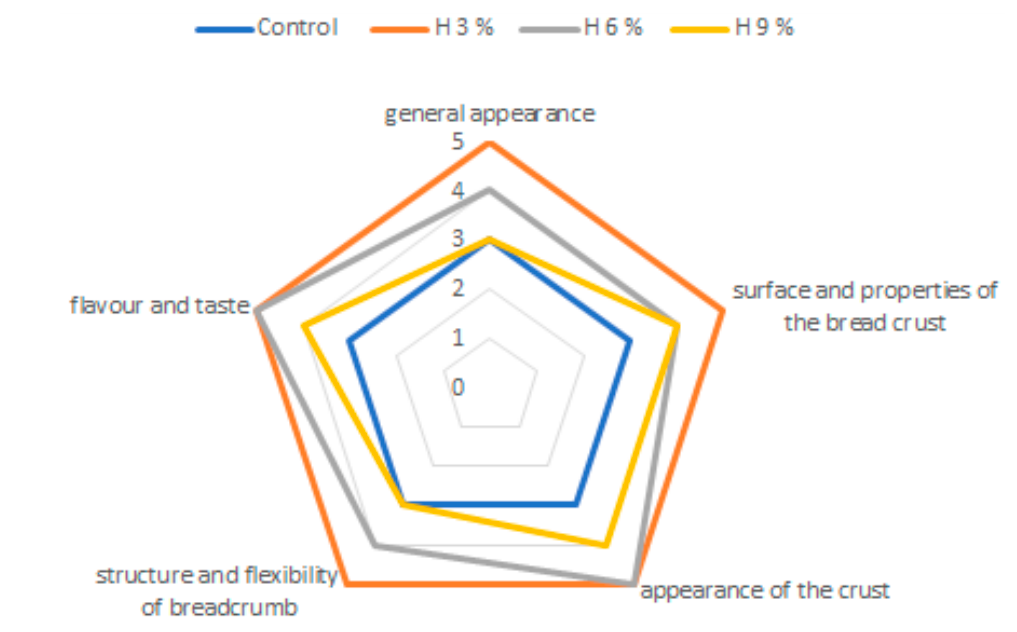
Figure 1. Results of sensory evaluation of breads with addition of Hucul black oat wholemeal flour (sum of all panellists). C—control bread; H3—bread with 3% Hucul addition; H6—bread with 6% Hucul addition; H9—bread with 9% Hucul addition; N3—bread with 3% Norik addition; N6—bread with 6% Norik addition; n.d.—not detected; N9—bread with 9% Norik addition.